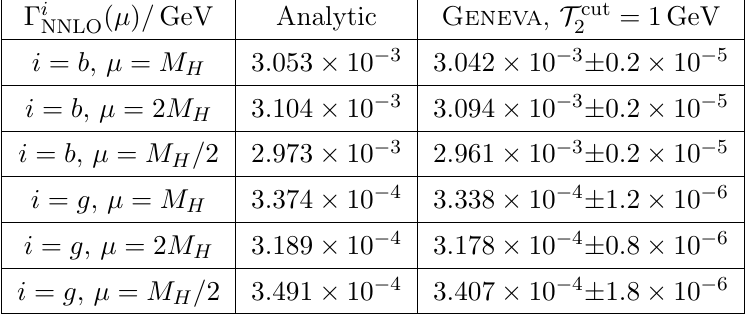
Table 1. Comparison of Higgs boson partial widths obtained from NNLO analytic expressions and at the partonic level from Geneva . Note that, due to the presence of the power corrections displayed in figure 4, the values do not agree exactly within the statistical error and therefore a reweighting must be